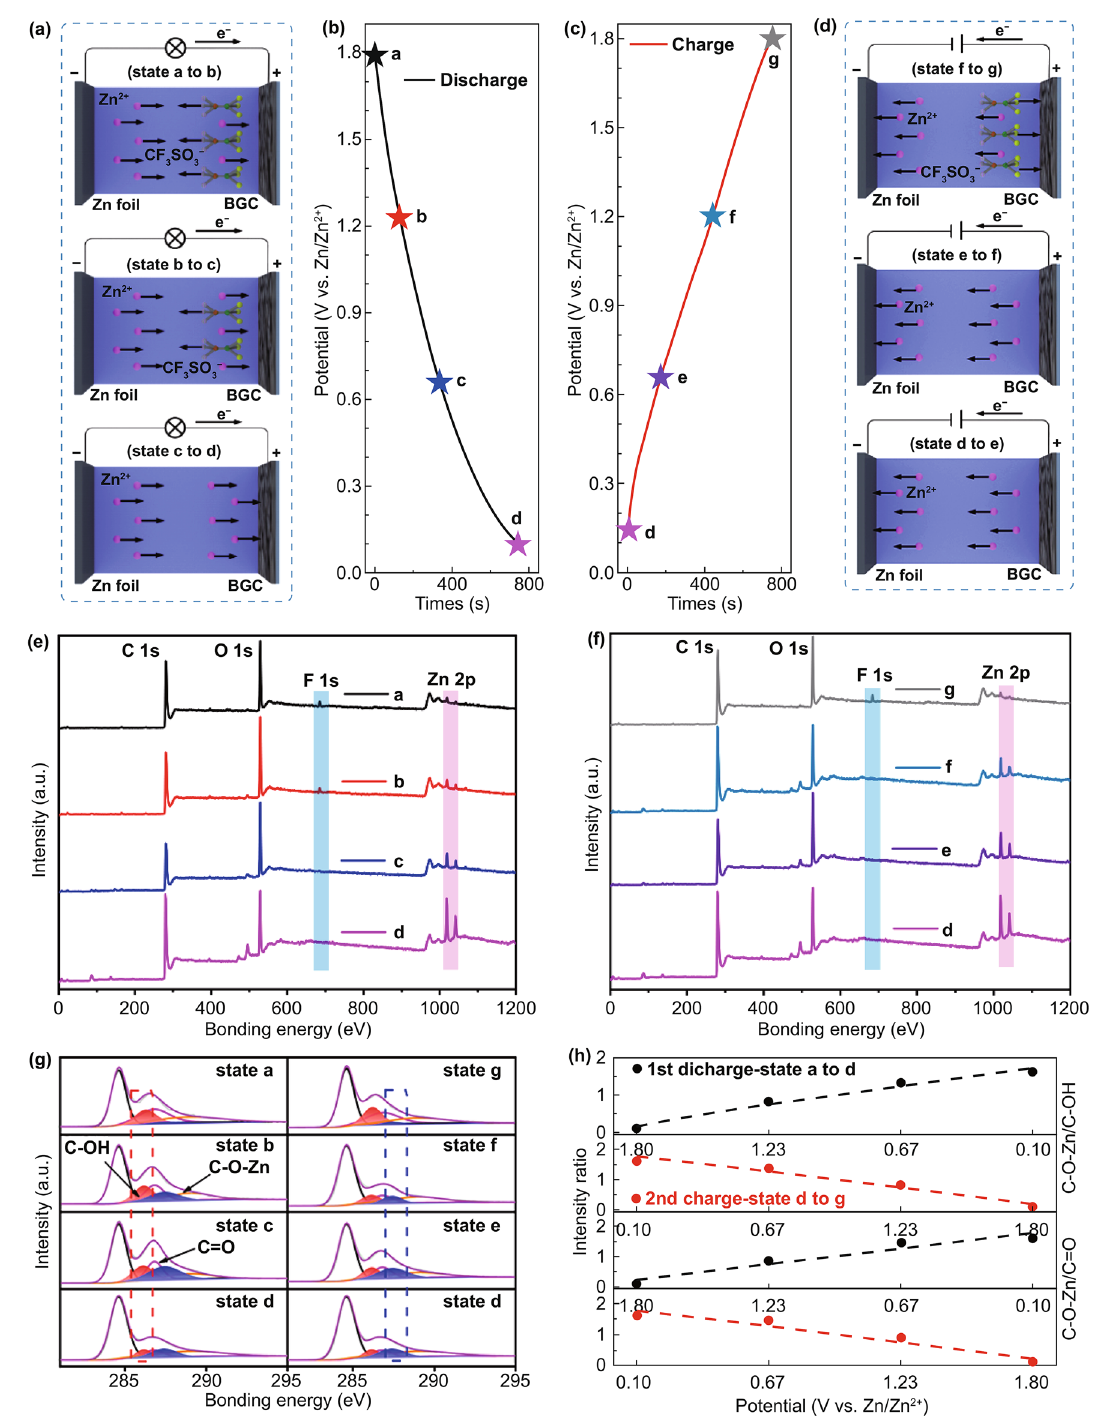
Fig. 3 a , d Schematic diagram of the cation and anion transportation during discharge/charge. b , c The selected voltage points in the discharge/ charge curves of BGC-750 for ex situ characterization. e , f Ex situ XPS spectra at the selected states. g Ex situ C 1 s XPS spectra at the selected states. h The intensity ratio of C–O–Zn/C–OH and C–O–Zn/C=O peaks according to